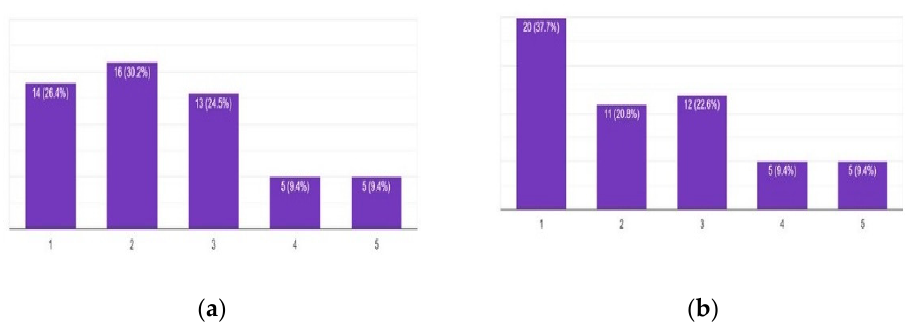
Figure 17. Participants’ opinion: ( a ) the occasional failures affect the students’ faith and cause them to lose their confidence to finish the work; ( b ) the occasional failures make students consider that their instructors are inadequate.